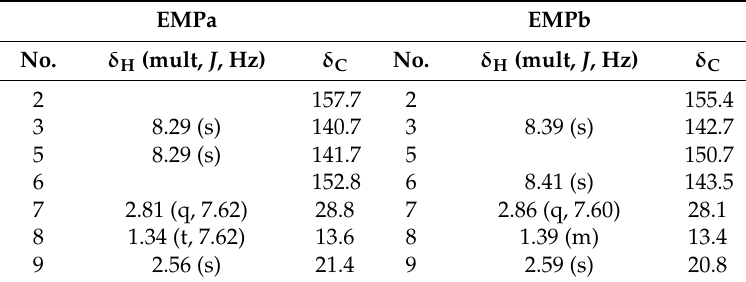
Table 1. 1 H- and 13 C-NMR data of 2-ethyl-5(6)-methylpyrazine a (EMPa) and 2-ethyl-5(6)-methylpyrazine b (EMPb) a